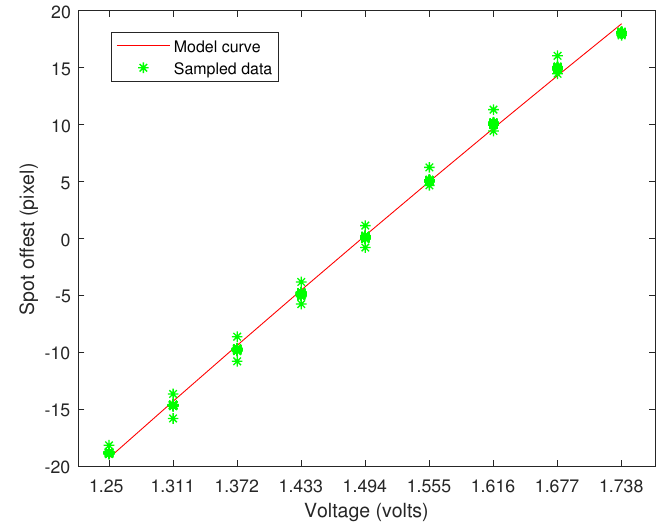
Figure 9. The fitting curve of both electrodes for the x coordinate of the 1st